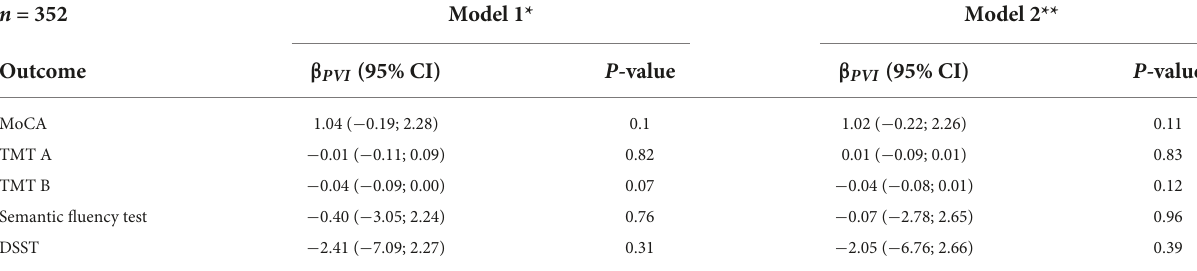
TABLE 4 Association between PVI and cognitive function in the propensity score matched population of patients with atrial fibrillation without a history of a prior PVI. n = 352 Model 1* Model 2**